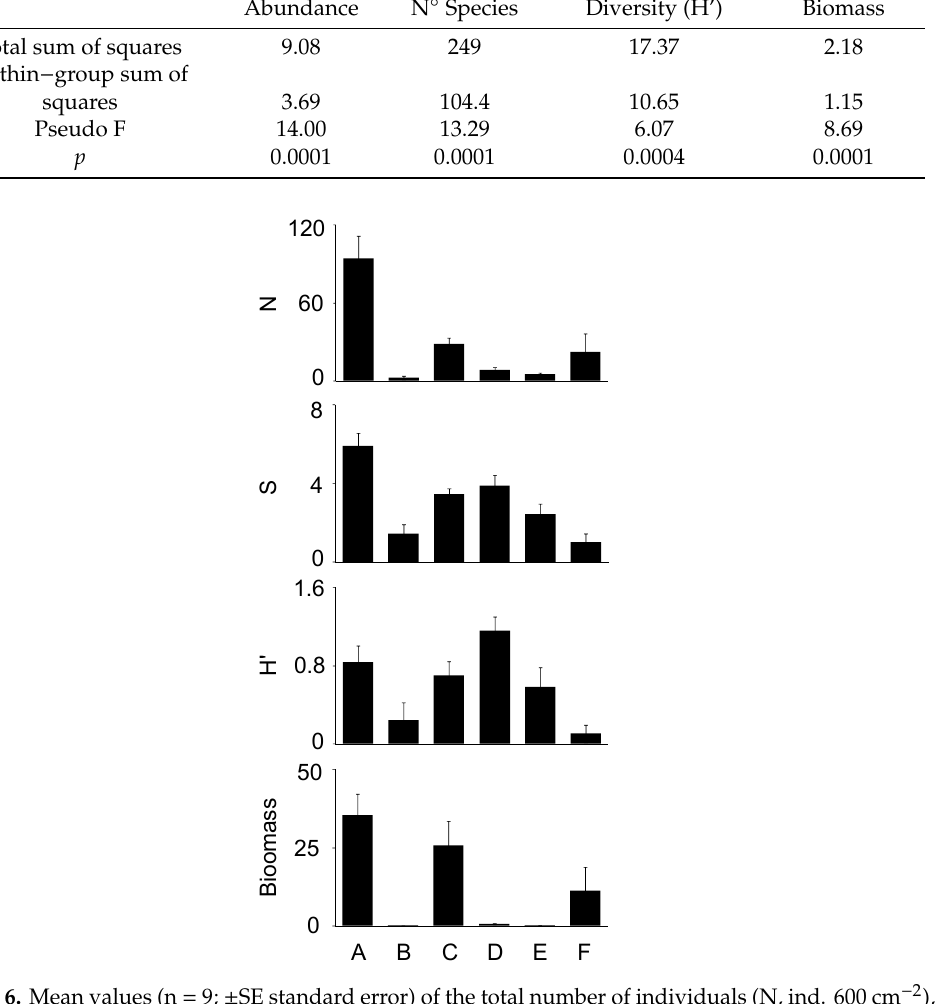
Figure 6. Mean values (n = 9; ± SE standard error) of the total number of individuals (N, ind. 600 cm − 2 ), total number of species (S), Shannon index (H’), and biomass (g.wet weight 600 cm − 2 ) at each site. Table 5. Results of PERMANOVA (based on Bray–Curtis similarity index) testing differences among sites (A, B, C, D, E, F) for the abundance of all the taxa. Comparisons of post − hoc test between all pairs of sites are also given. Significant comparisons at p < 0.05 are marked by * and at p < 0.01 by **. The Bonferroni correction was used. Permutation number = 9999.